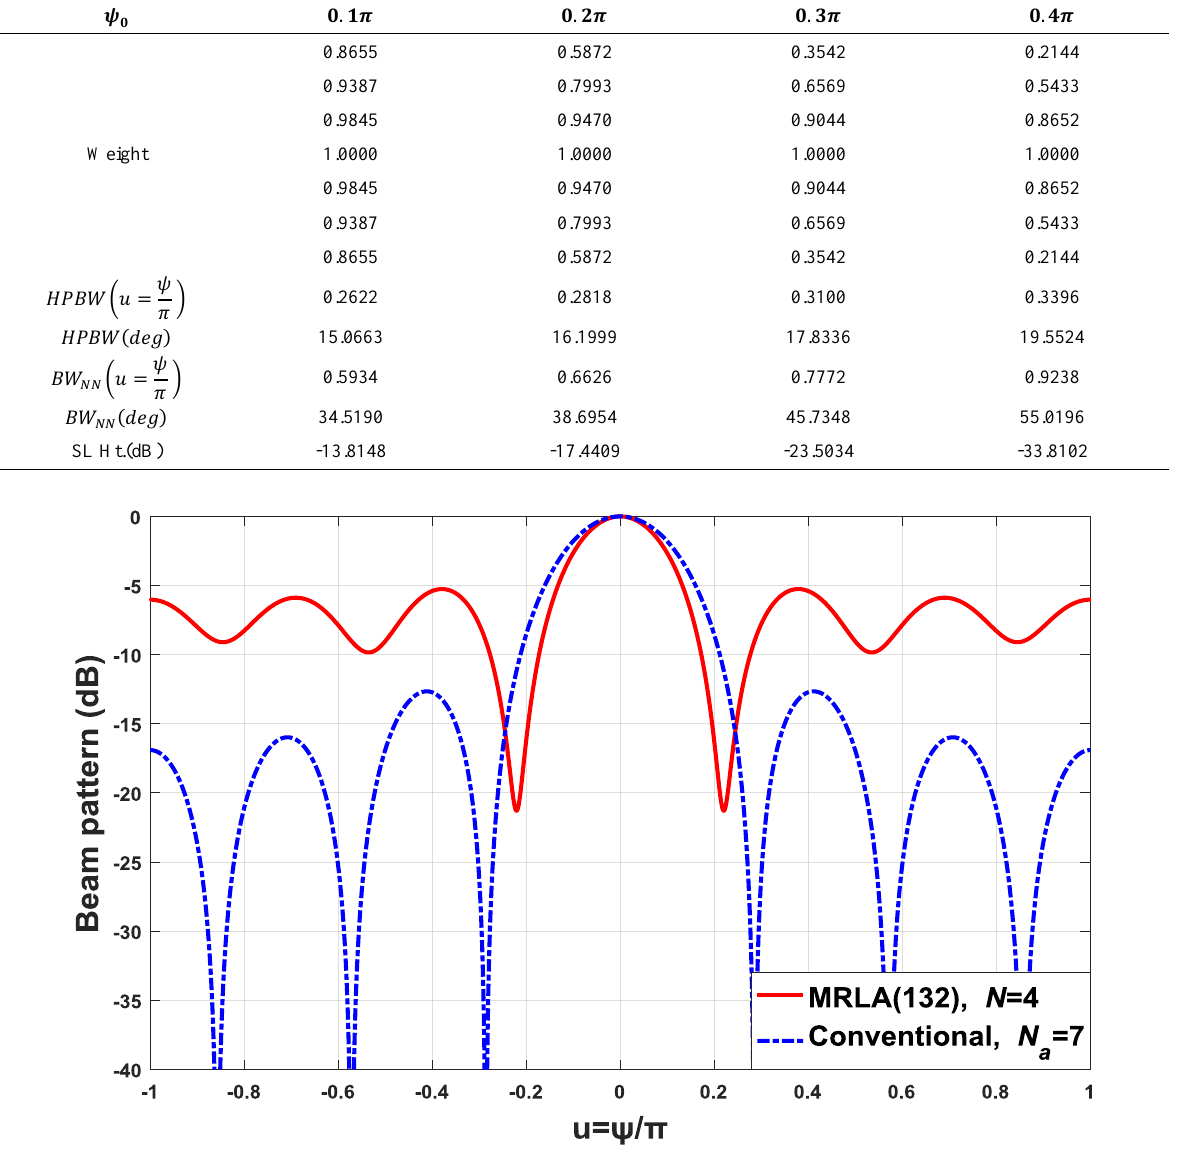
Table 6. Half Power Beam Width ( 𝑯𝑷𝑩𝑾 ) and 𝑩𝑾 𝑵𝑵 (null to null) for different Weight.